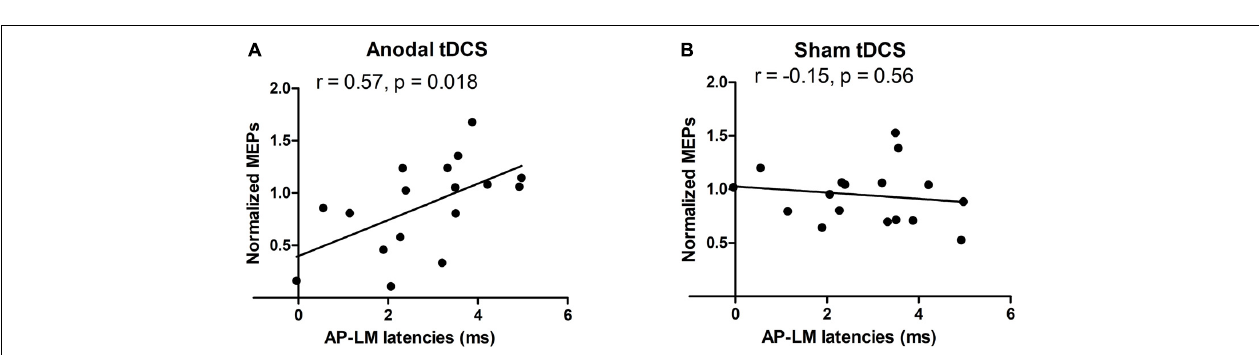
FIGURE 3 | MEP results. (A) Raw amplitudes of MEPs after either anodal or sham TDCS (mean ± SE). At baseline, there was a significant difference in MEP amplitudes between TDCS and sham sessions ( p < 0.05, paired t-test). (B) Group results of normalized amplitudes of MEPs after either anodal or sham TDCS (mean ± SE, n = 17). Normalized amplitudes were calculated by dividing the amplitudes of MEPs just after or 1 hour after TDCS by ones at baseline. No interaction could be detected.